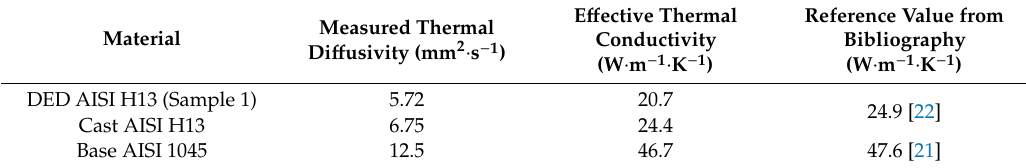
Table 6. Thermal conductivities.